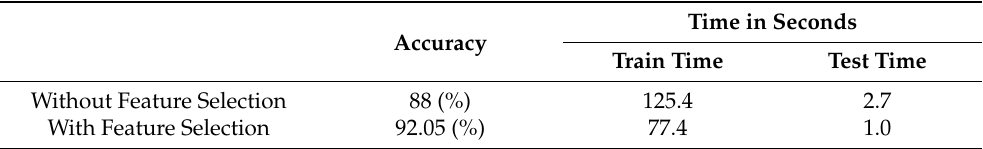
Table 9. Comparison performance with feature selection and without feature selection (training vs. testing